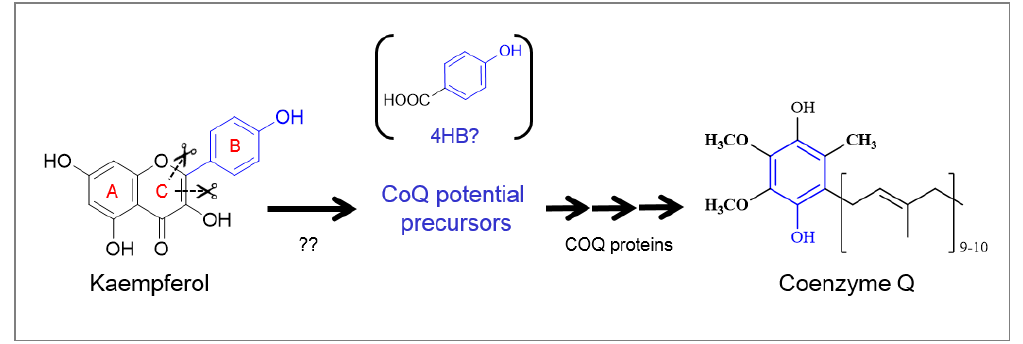
Figure 2. Model of kaempferol cleavage in kidney cells. Inside the cells, the B-ring of kaempferol is cleaved via a presumptive peroxidative mechanism, to produce CoQ precursors (most likely 4HB) that will enter the CoQ biosynthetic pathway to produce CoQ. The additional supply of this ring precursor is able to increase CoQ content in cells.